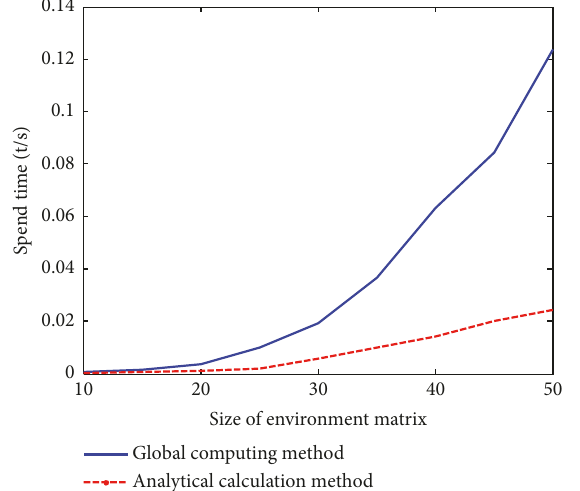
Figure 9: Comparison of the time cost by the analytical approach and the global